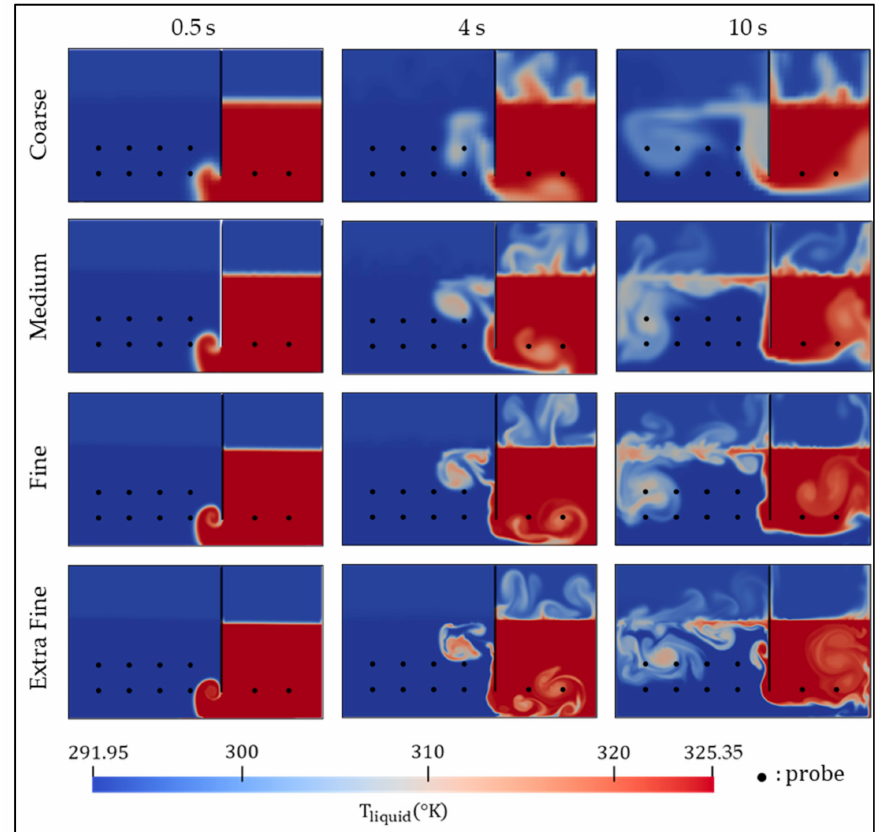
Figure 7. Temperature fields at different times for the four meshes (CFL =